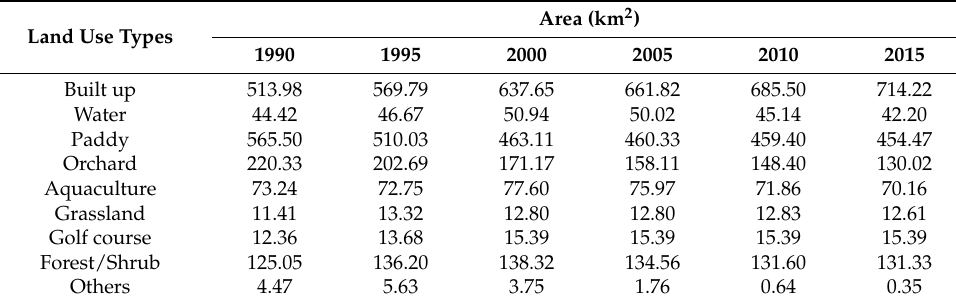
Table 7. Area of land use types in Bangkok from 1990 to 2015.